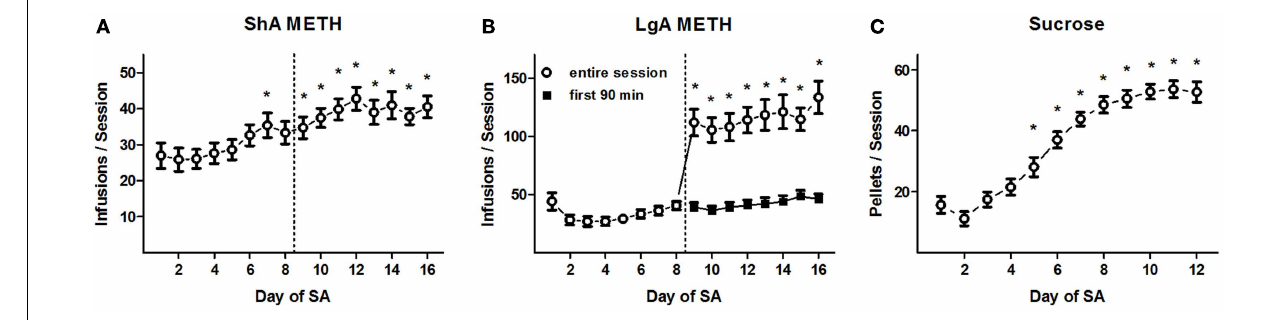
reinforcements during the initial 90min of the 6-h training sessions (Days 9–16, filled circles). * p < 0.05 different from reinforcements delivered during Days 1–8 (Newman–Keuls tests). Dotted line demarcates Phase 1 (left side) and Phase 2 (right side) of METH SA training. (C) Mean ( ± SEM) number of sucrose pellet deliveries per 30-min training session in Experiment 3. * p < 0.05 different from reinforcements delivered during Days 1–3 (Newman–Keuls